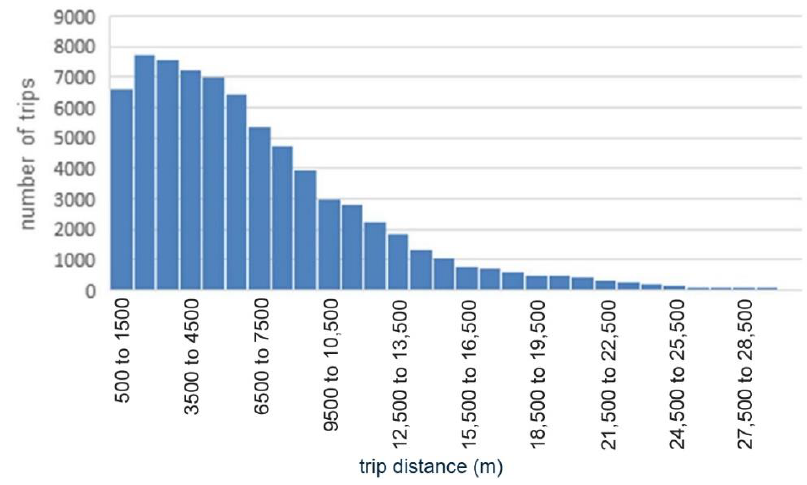
Figure 4. Temporal variation in bicycle traffic volumes measured by the digital bicycle counters in Berlin. Data source: Berlin Senate. Figure source: the authors.